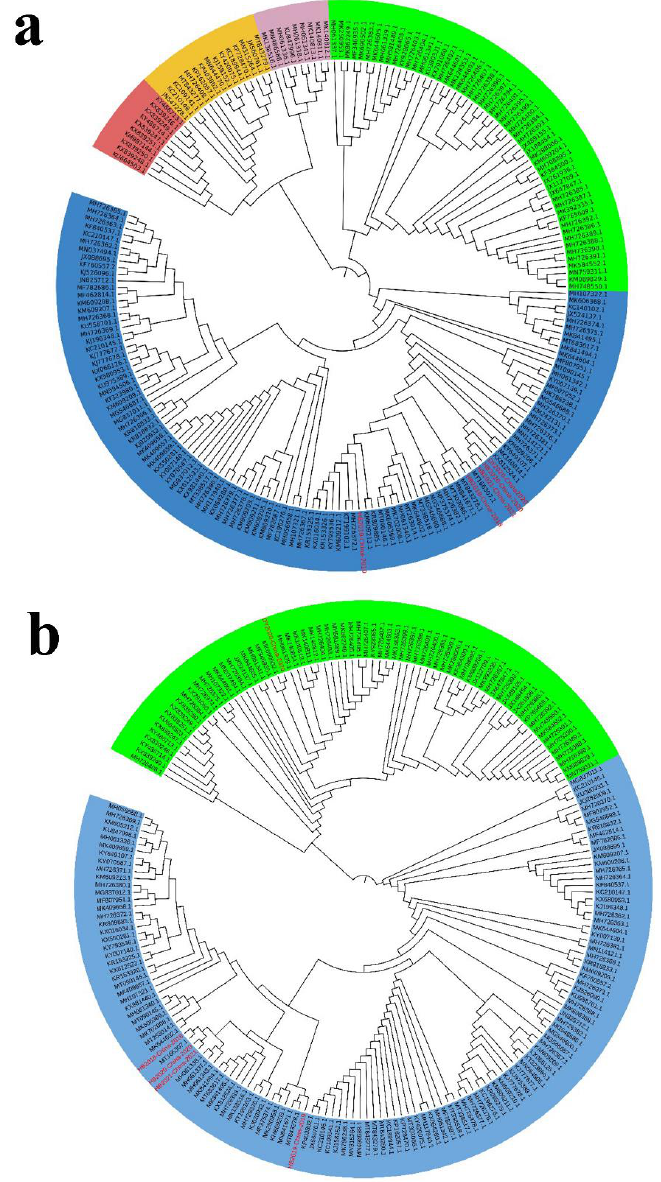
Figure 4. The phylogenetic analysis based on the S genes and ORF3 genes of the PEDV strains isolated in this study. ( a ) The phylogenetic analysis of the S gene. PEDV was divided into 5 categories: GI-a (Blue), GI-b (Green), GII-a (light red), GII-b (Yellow), and GII-c (light pink). The strains isolated in this study are highlighted in red color. ( b ). The phylogenetic analysis of the ORF3 gene. PEDV was divided into two categories: A group (Blue) and B group (Green). The strains isolated in this study are highlighted in red color. The phylogenetic trees were generated by the neighbor-joining method in MEGAX software with a p-distance model, using 1000 bootstrap replicates.